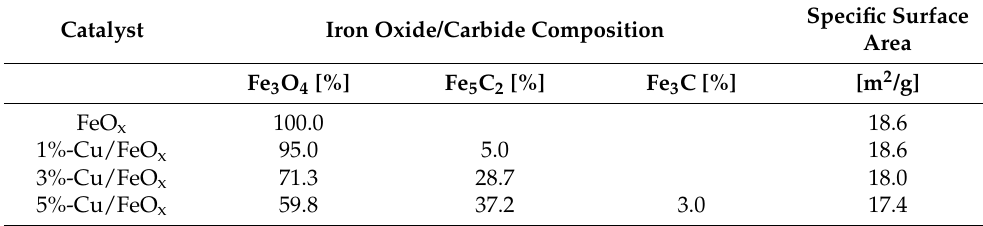
Table 2. Fractions of various forms of iron oxide and iron carbide components in the spent catalysts, obtained from XRD data using Rietveld refinement of analysis and specific surface area of spent catalysts, as determined from adsorption/desorption of nitrogen on the surface of the spent catalysts. Multipoint BET was assessed using Roquerol’s